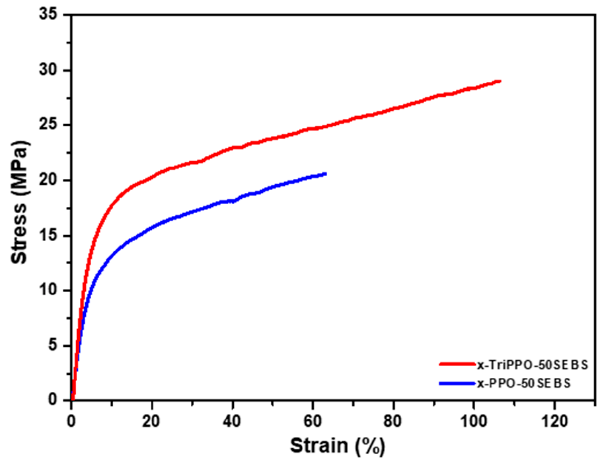
Figure 4. The crosslinked PPO–SEBS membranes’ stress–strain curves.